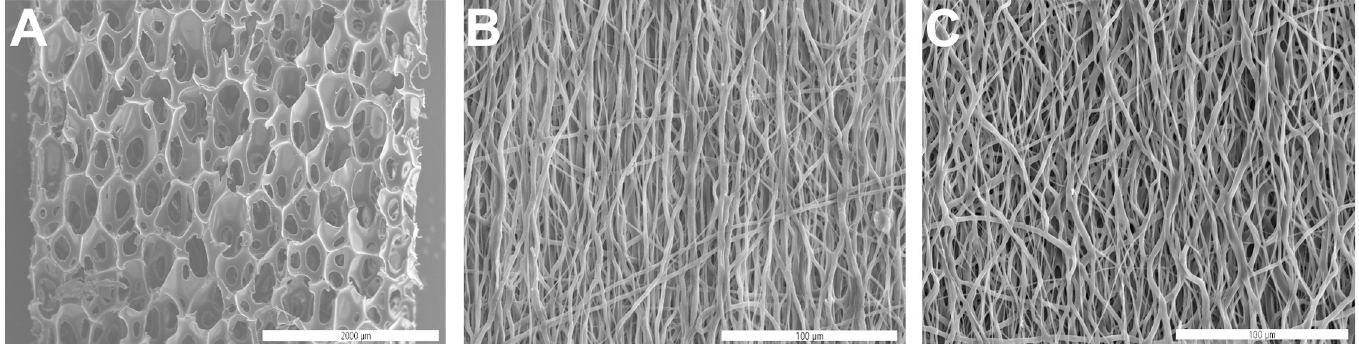
Fig 2. Scanning electron microscopy of the implant materials. Porous polymer patch (A) , unmodified PCL fiber mat (B) and PCL fiber mat modified with CS-g-PCL (C) . Scale bars: 200 μ m (A), 100 μ m (B, C).